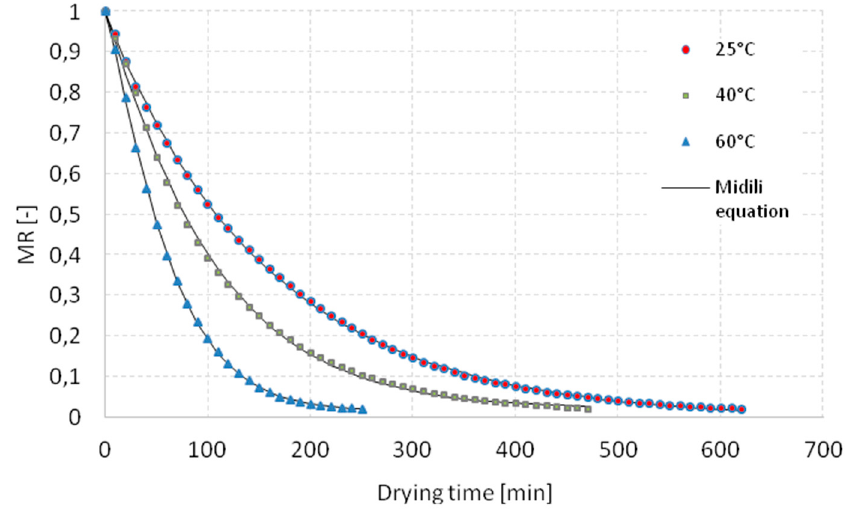
Figure 2. Drying curves of the air-drying process of wild strawberry fruits.